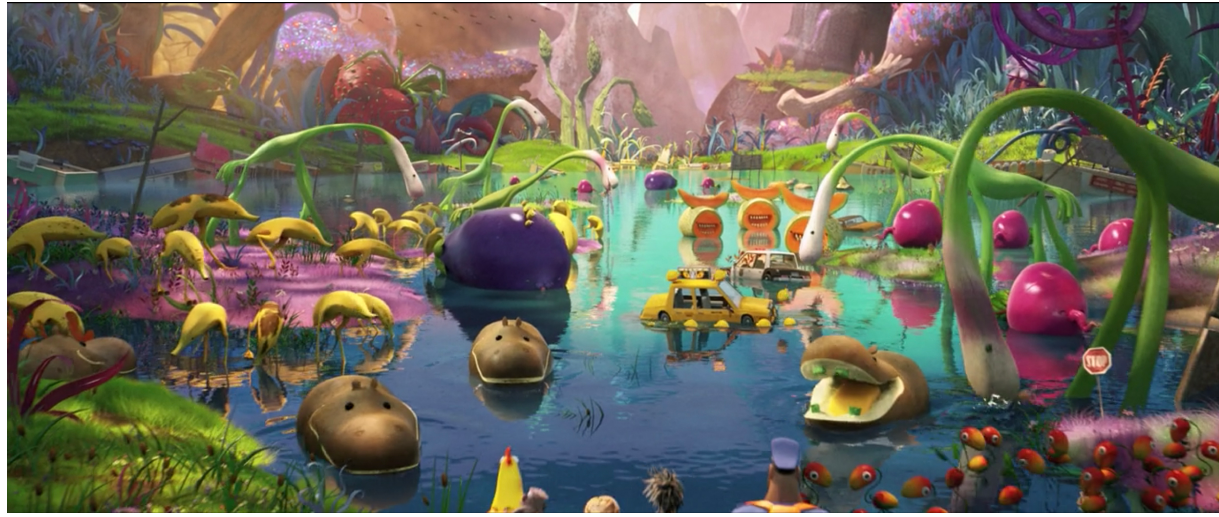
Figure 1: The foodimals and their ecosystem ( Cloudy 2